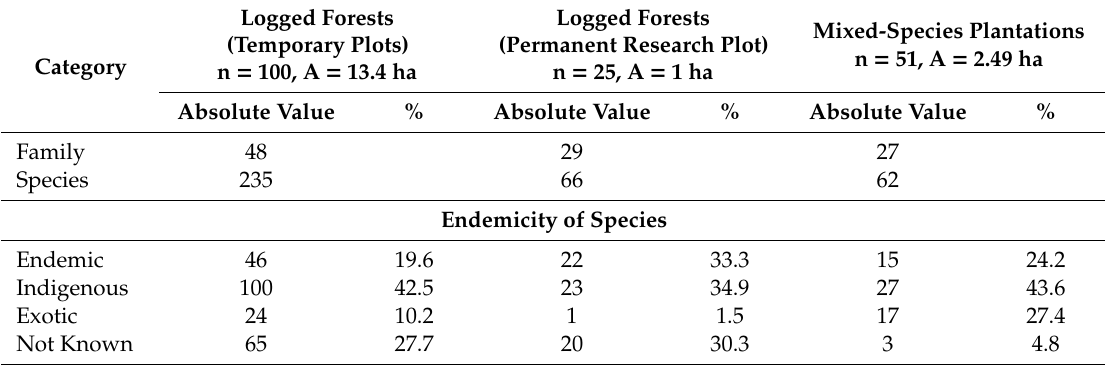
Table 2. Endemicity of species found in the study sites in Southern Leyte and Leyte,